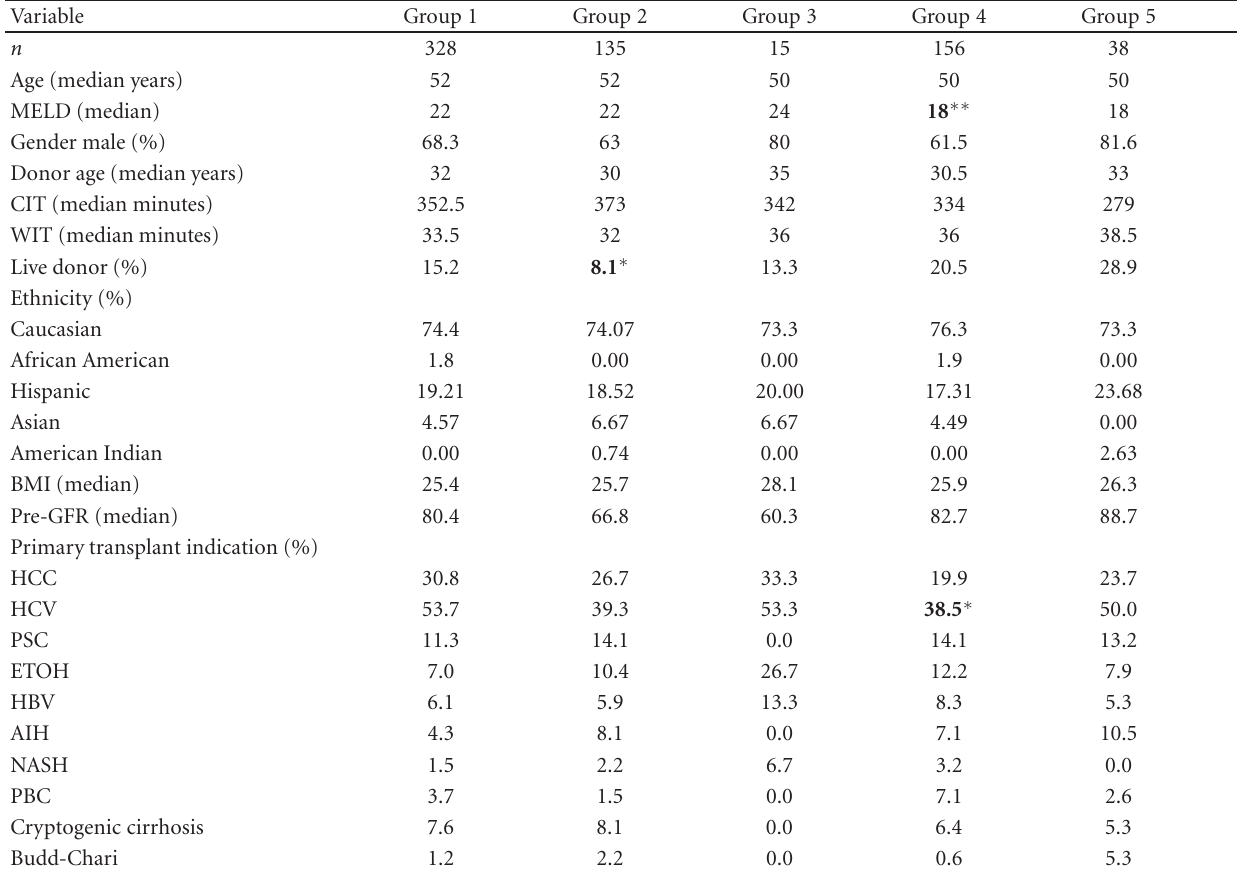
Table 1: Recipient demographics.